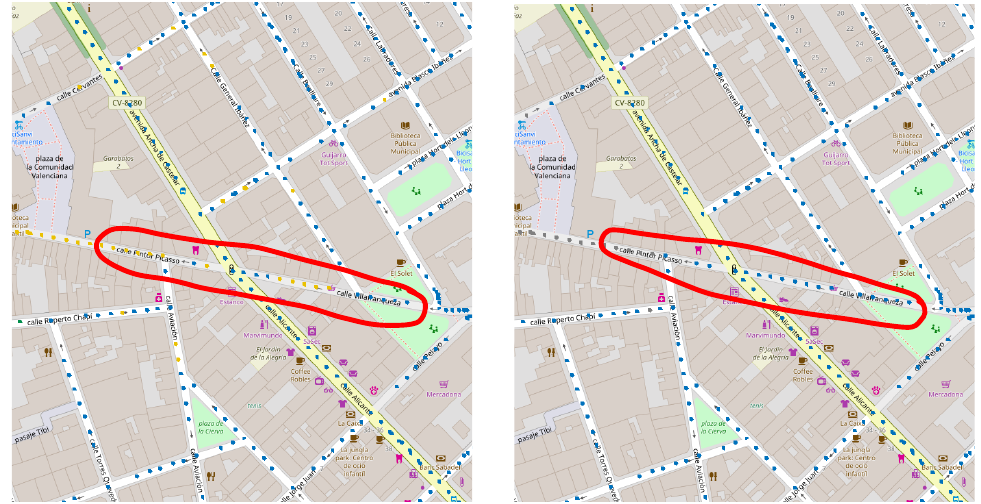
Figure 22. Comparison of smoothing results before ( left ) and after ( right ) applying KNN algorithm. A red circle indicates changes detected on